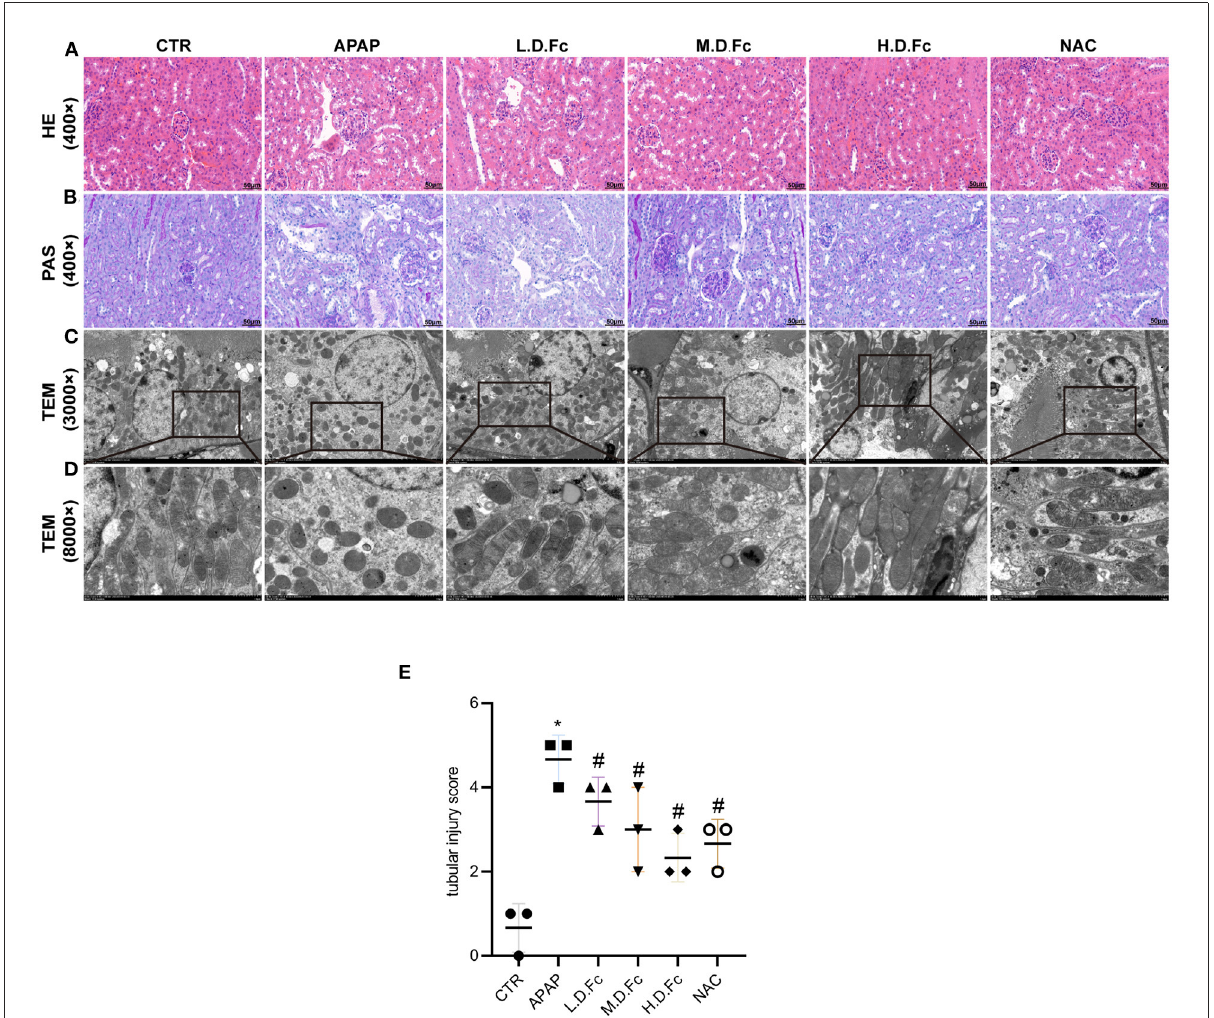
FIGURE2 Notoginsenoside Fc improved renal histopathology and mitochondrial morphology abnormalities in renal tubular cells. (A,B) Renal histology evaluations were performed with HE and PAS staining (original magnification × 400, bars = 50 µ m). (C) Mitochondria morphology alterations in renal tubular cells were observed by TEM (original magnification × 3,000, bars = 5 µ m). (D) High-magnification TEM micrographs of mitochondrial ultrastructure (original magnification × 8,000, bars = 1 µ m). (E) Tubular injury score. Results were expressed as mean ± SD. * P